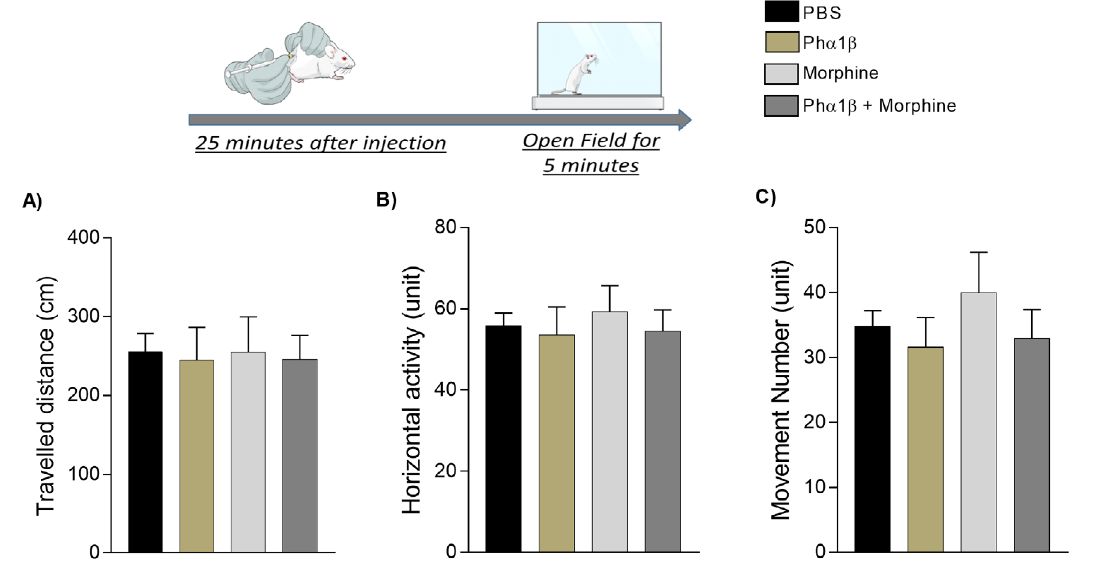
Figure 5. Antinociceptive doses of recombinant Phα1β and morphine (alone or in combination) cause no alterations in spontaneous motor performance in mice. Top image: experimental test scheme. Drugs were injected at doses necessary to cause 50% of MPE in the mechanical hypersensitivity assays. The open-field test was performed 20 minutes after treatment. Data were recorded within 5 minutes. (A) Total travelled distance. (B) The total number of movements (including flinch, tail-flick, grooming, jumping). (C) The total duration of the movements. Data are expressed as mean ± SEM (n = 6 animals per